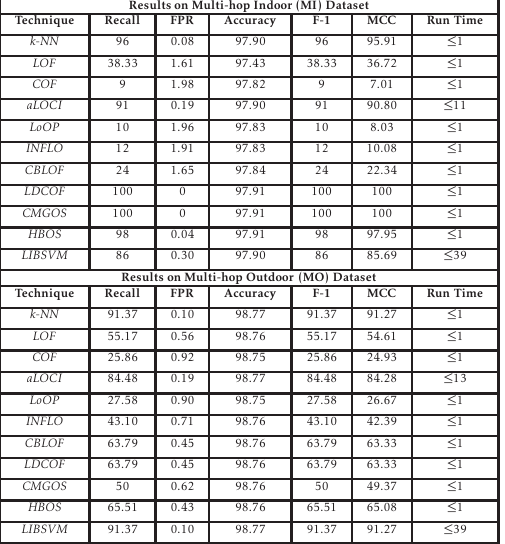
Table 6. Performance of Anomaly Detection Techniques on Datasets with Injected Anomalies ResultsonMulti-hopIndoor(MI)Dataset Technique